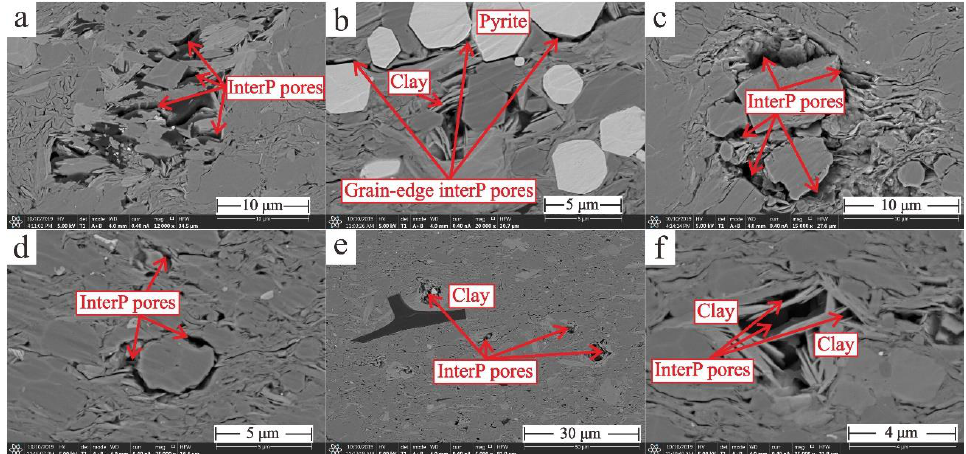
Figure 3. FE-SEM images of interparticle pores. ( a ) SK1S16, mudstone; ( b ) SK1S38, mudstone; ( c ) SK1S16, mudstone; ( d ) SK1S38, mudstone; ( e ) SK1S38, mudstone; and ( f ) SK1S38, mudstone.